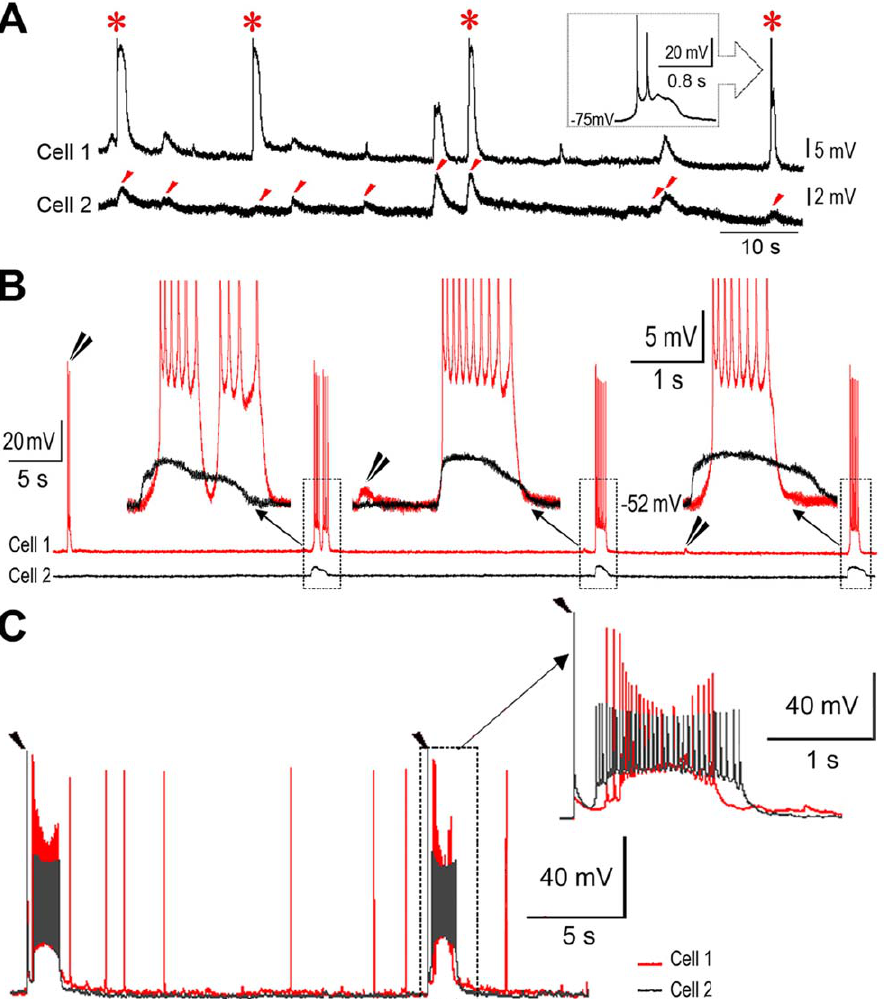
Figure 1. Recordings of synchronized responses between individual neurons in an electrical network of rat PFC. A . Synchronized spontaneous depolarizations (marked with red arrow heads). Responses were recorded between two PCs (cell 1 and cell 2) under calcium-free conditions. The depolarizations of cell 1 lead to a few action potentials (APs) (for clarity, APs were truncated as marked with stars). B . Synchronized spontaneous bursts and depolarizations. Recording procedure was the same as in A . Bursts of cell 1 were synchronized with depolarizations of cell 2. The synchronized responses varied from having equal time courses up to 750 ms differences in duration (as shown in the insets, APs were truncated). Solitary or un-synchronized responses of cell 1 are indicated with double black arrow heads. C . Experimentally evoked synchronizing responses. Two neurons (cell 1 and cell2) were simultaneously recorded while two separated extracellular stimuli (20 m A for a duration of 2 ms; marked with single black arrow heads) were delivered locally at 30 s intervals. Bursting responses were provoked in both cells immediately after either of the stimulating artifacts. These bursts were synchronized yet had un-equal durations (see the inset). Following the evoked bursts, spontaneous APs continued to be captured from cell 1, but none from cell